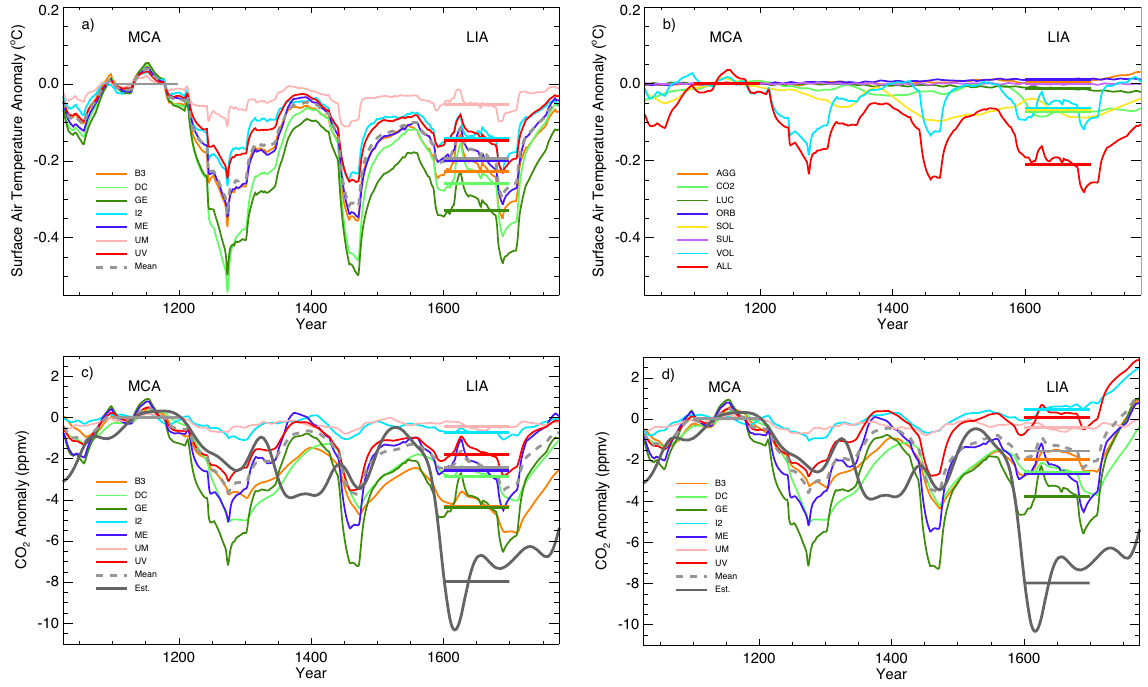
Fig. 11. Comparison of global surface temperature and CO 2 responses over the preindustrial portion of the last millennium. The surface air temperature responses in (a) are from the freely evolving CO 2 simulations with only natural forcing. The contributions of individual forcing components to the temperature response, shown in (b) , are model averages from experiments with specified CO 2 . The model averages in (b) are from 11 models: B3, C2, C3, DC, GE, I2, LO, MI, ME, UM and UV. Maximum Northern Hemisphere SAT changes between the MCA and LIA are estimated to be about 0.4 ◦ C from palaeoclimate reconstructions, but this is highly uncertain (Frank et al., 2010). The CO 2 response is shown for the freely evolving CO 2 simulations with only natural forcing in (c) and all-forcing in (d) . When multiple model results are shown, the model mean is indicated by a dashed grey line. The solid dark grey lines in (c) and (d) are an estimate of reconstructed CO 2 from the PMIP3 forcing dataset (Schmidt et al., 2012). Horizontal lines over two, century-long index periods (1100–1200 and 1600– 1700), which roughly correspond to the Medieval Climate Anomaly (MCA) and Little Ice Age (LIA), indicate model or data averages over these periods. All model results and data estimates are shown as anomalies from the average over the years 1100 to 1200 and were processed with a 30yr moving average, rectangular